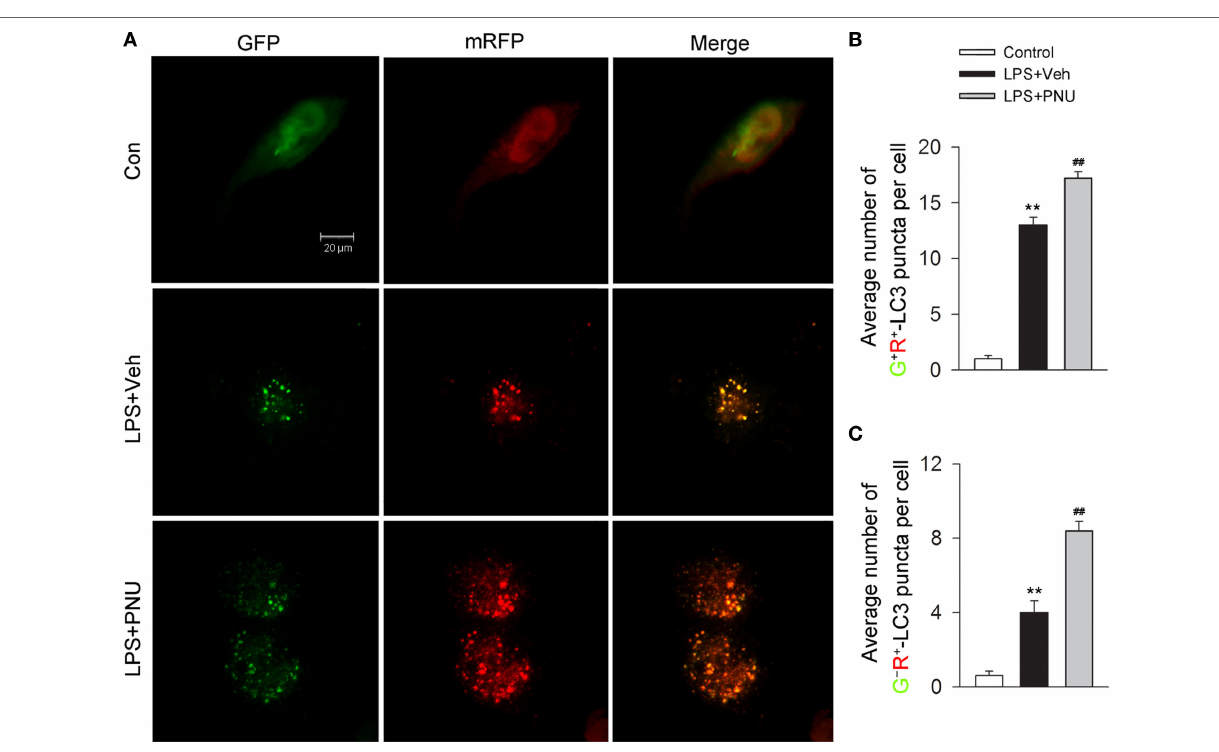
FigUre 6 | α 7nachr activation increases the level of autophagy flux in BV2 microglia stimulated with lipopolysaccharide (lPs) . (a) BV2 microglia were pretreated with vehicle or PNU282987 (10 µM) and representative images of mRFP-GFP-LC3 vector were shown by fluorescent detection. PNU282987 significantly increased the level of autophagy compared with vehicle ( n = 5 per group). Scale bar, 20 µm. (B,c) Quantitative analysis of the number of yellow autophagosomes and red autolysosomes. ** P < 0.01 vs normal, ## P < 0.01 vs Veh. Veh, vehicle; PNU, PNU282987.